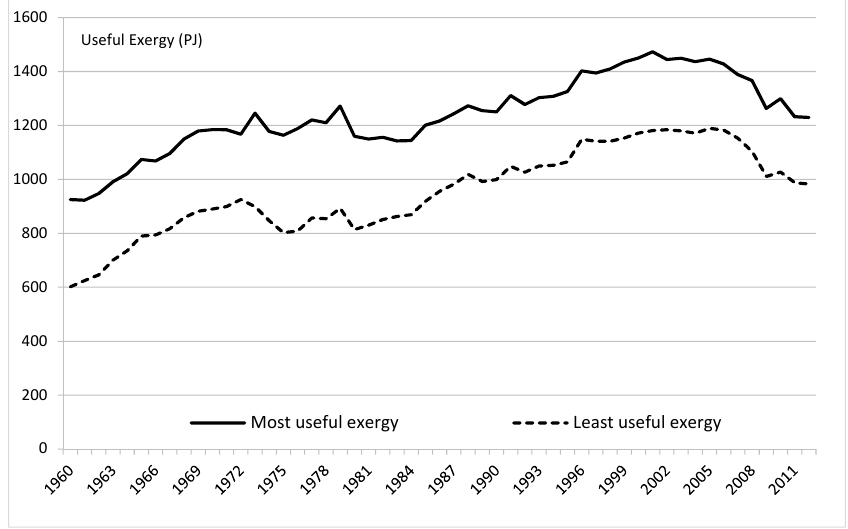
Figure 15. Range of estimates of national useful exergy consumption, when using a combination of all methods of estimating end-use efficiencies.